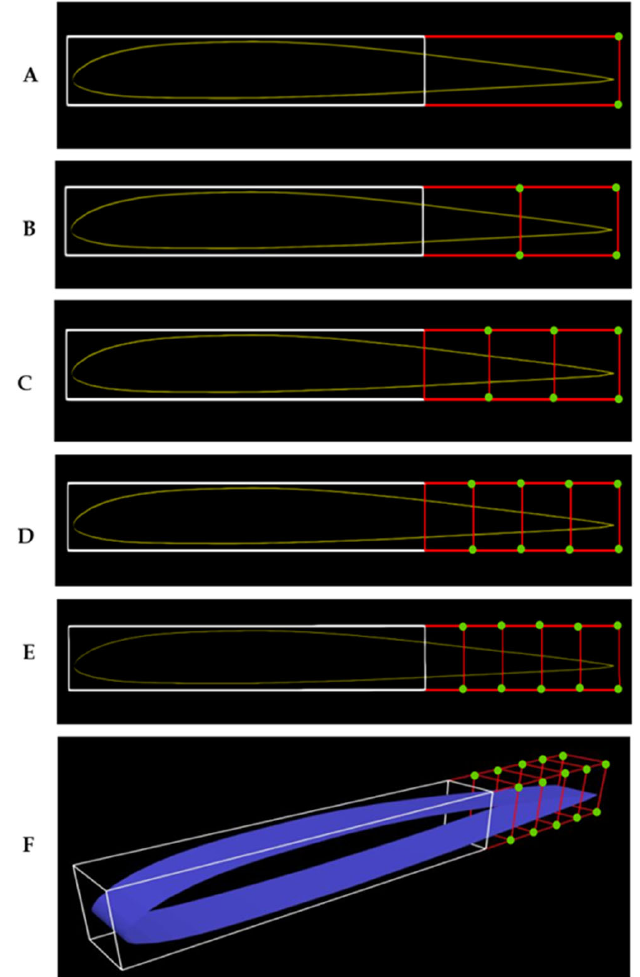
Figure 2. Embedded UAS ‐ S45 airfoil in FFD blocks for five cases with ( A ) 8, ( B ) 12, ( C ) 16, ( D ) 20, ( E ) 24 control points from a side view, and ( F ) an isometric view of the FFD block with 24 control points.